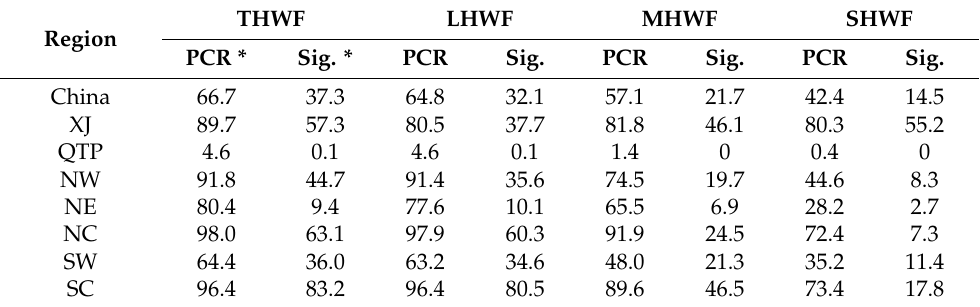
Figure 6. Temporal changes of light, moderate, and severe heatwave frequencies (to be regarded as LHWF, MHWF, and SHWF, respectively) over different subregions during 1979–2018. ( a ) XJ, ( b ) NW, ( c ) NE, ( d ) NC, ( e ) SW, and ( f ) SC. Since trend of HWF over QTP at region-scale was far less than 0.01 d/decade and was not significant, it was omitted here. THWF = total heatwave frequency, which means sum of LHWF, MHWF, and SHWF. Table 3. Statistics of positive change rate (PCR) and significance (Sig.) percentage (%) in different